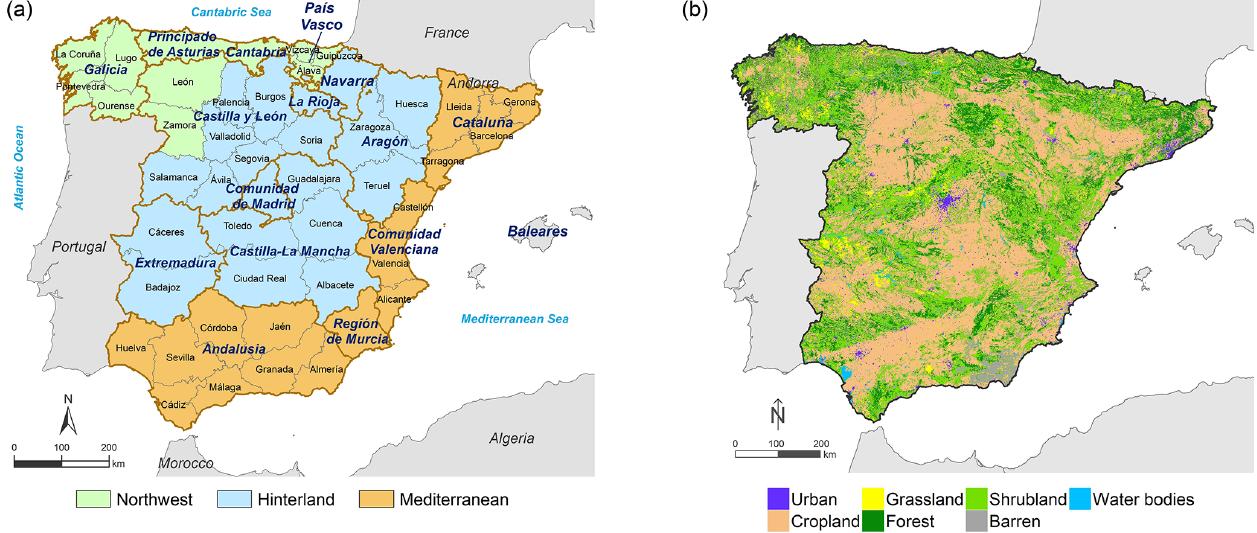
Figure 1. Spatial distribution of the three regions (Northwest, Hinterland and Mediterranean), NUTS3 and NUTS2 units in mainland Spain (a) and generalized land cover from CLC 2006 (b) . Table 1. Statistical summary of fire regime features 1974–2013. S: spring–summer; W: autumn–winter. In parentheses, the first value corre- sponds to inter-region percentage and the second value to intra-region percentage. Burned area data expressed in square kilometres. Region